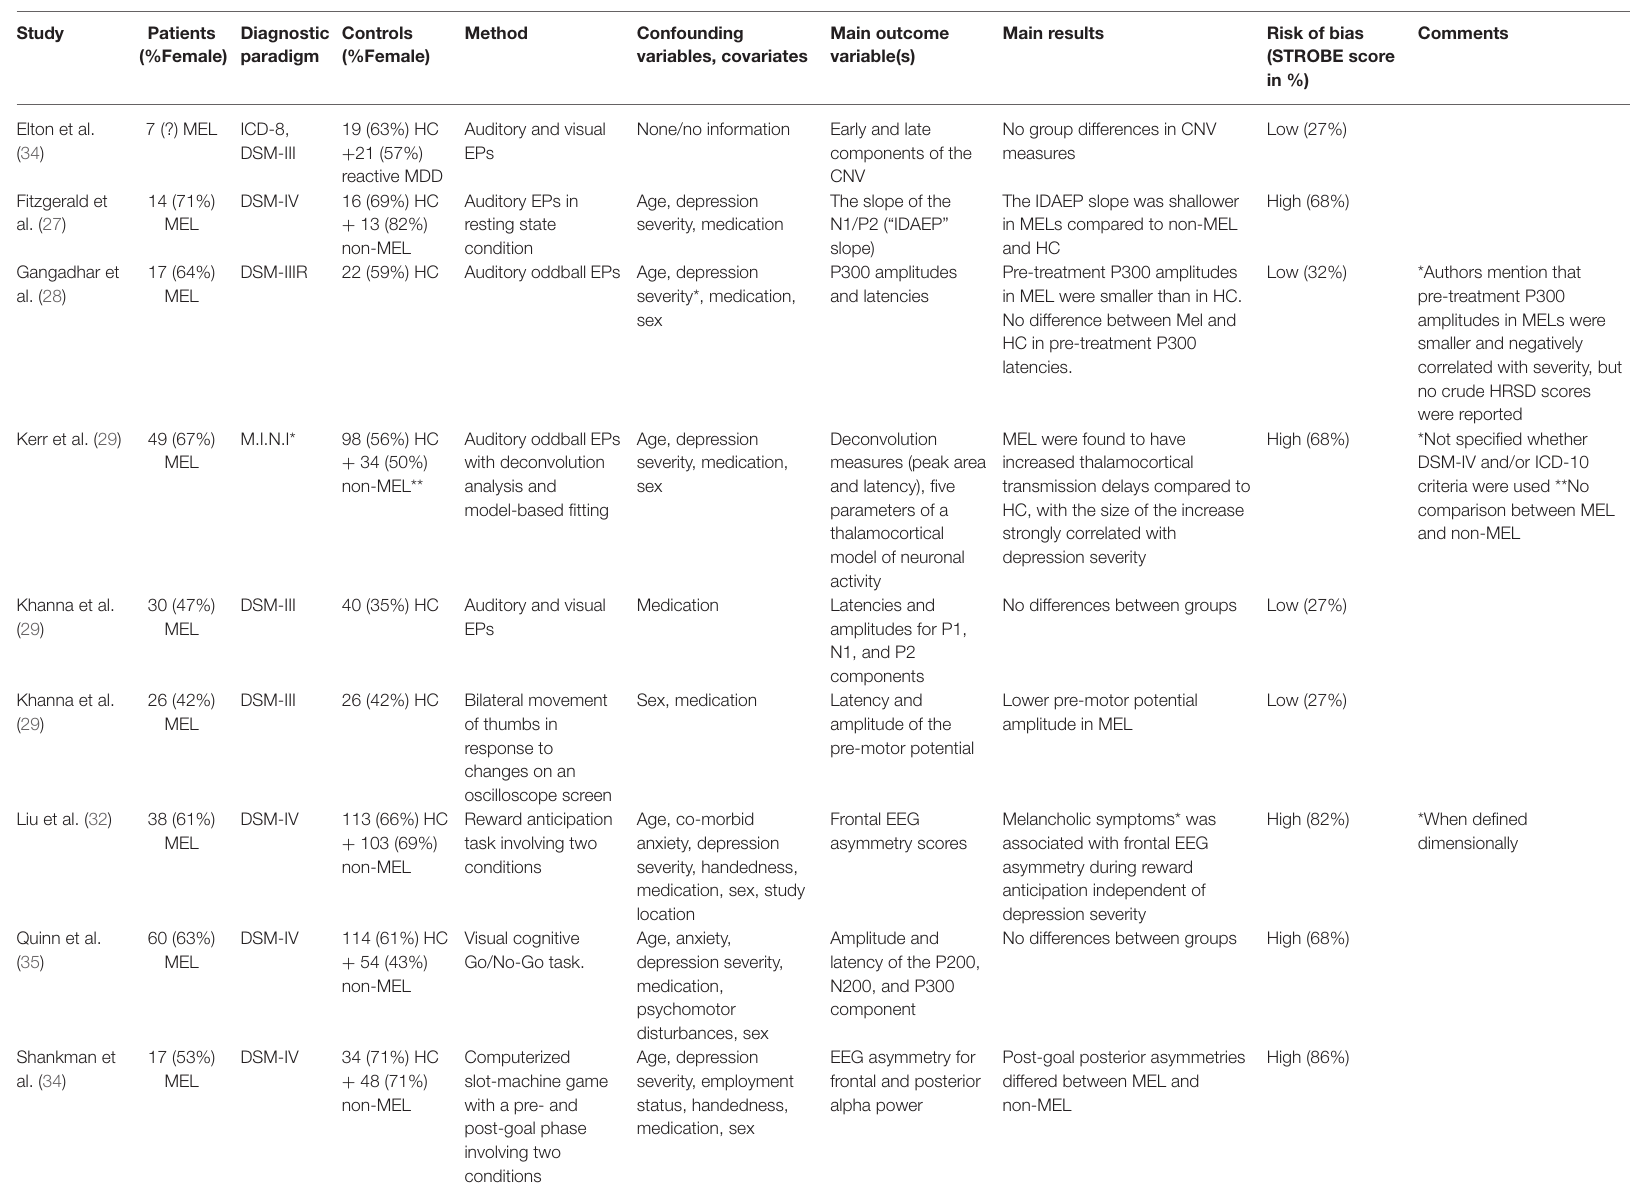
TABLE 1B | Summary of ERP